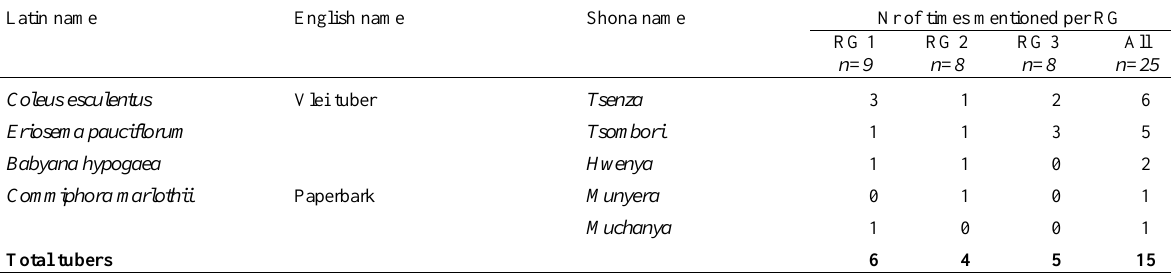
Table A3.5: Wild roots/tubers, species names and collection